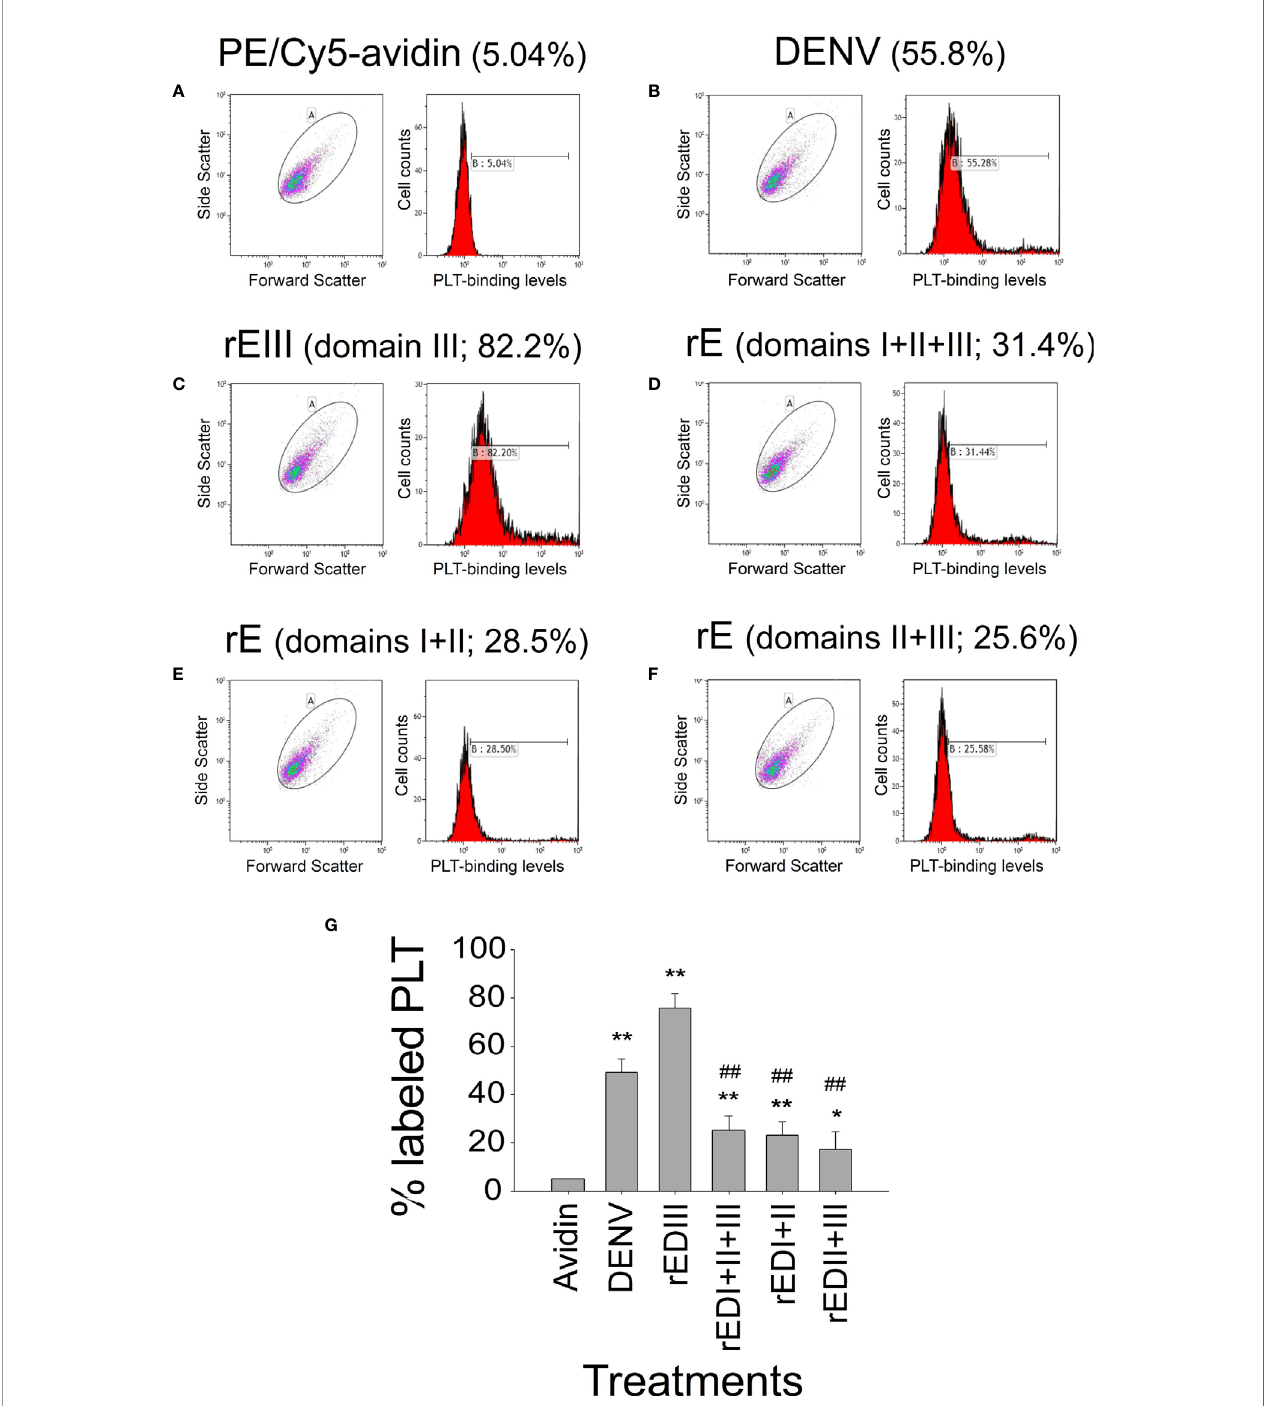
FIGURE 1 | Platelet-binding property of DENV and different recombinant DENV envelope protein (rE) fragments. Flow cytometry analysis of the platelet-binding properties of biotinylated DENV and recombinant DENV envelope proteins (rEs) through PE/Cy5-avidin labeling. (A) Platelet PE/Cy5-avidin binding signal served as the background level. The respective blots and histograms on the platelet-binding of (B) DENV, (C) rE (domain III), (D) rE (domain I + II + III), (E) rE (domain I + II), and (F) rE (domain II + III) were indicated, and (G) quanti fi ed. n = 6, * P < 0.05, ** P < 0.01 vs. avidin groups; ## P < 0.01 vs. rEIII groups. DENV2 PL046 viral particles were used in this and the following fi